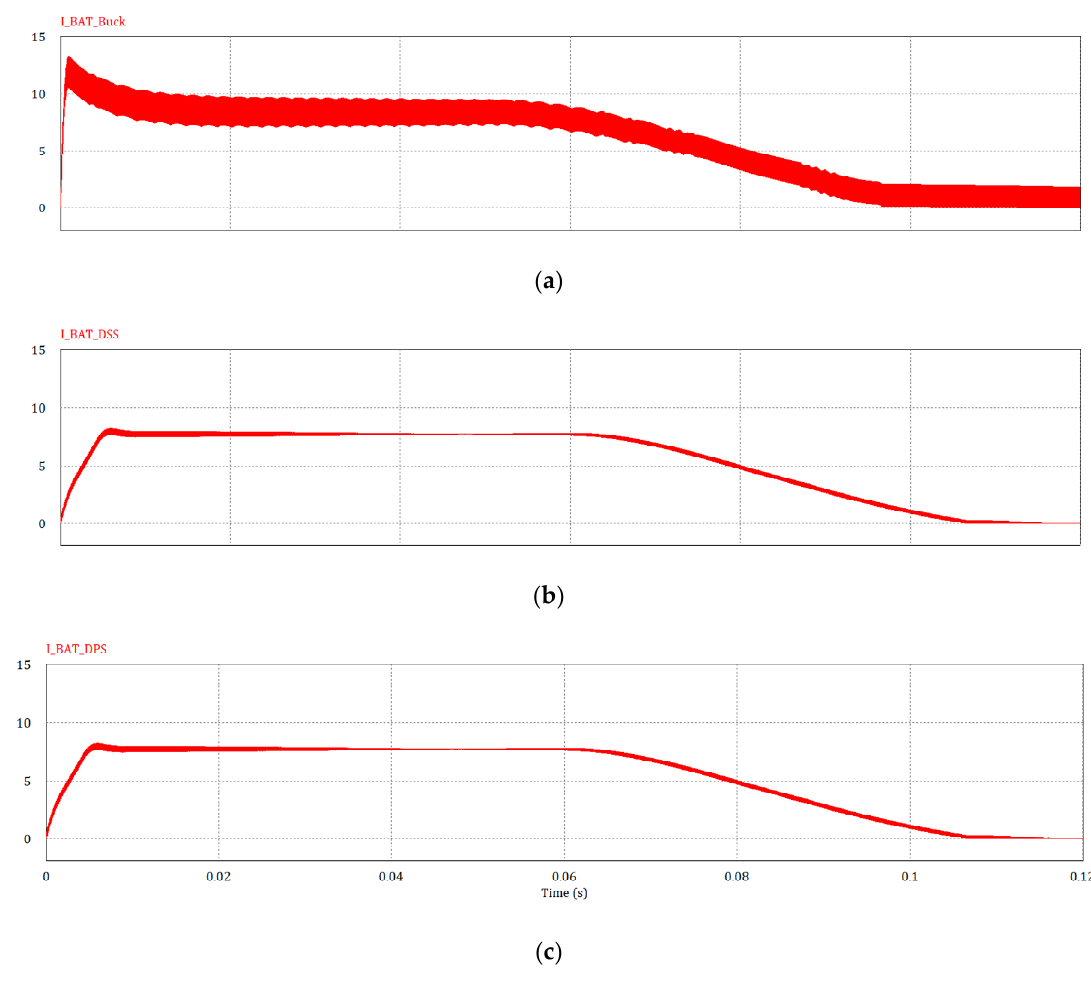
Figure 14. Comparison between the battery charge simulation results of the ( a ) buck converter, ( b ) DSS-MLC, and ( c ) DPS-MLC.